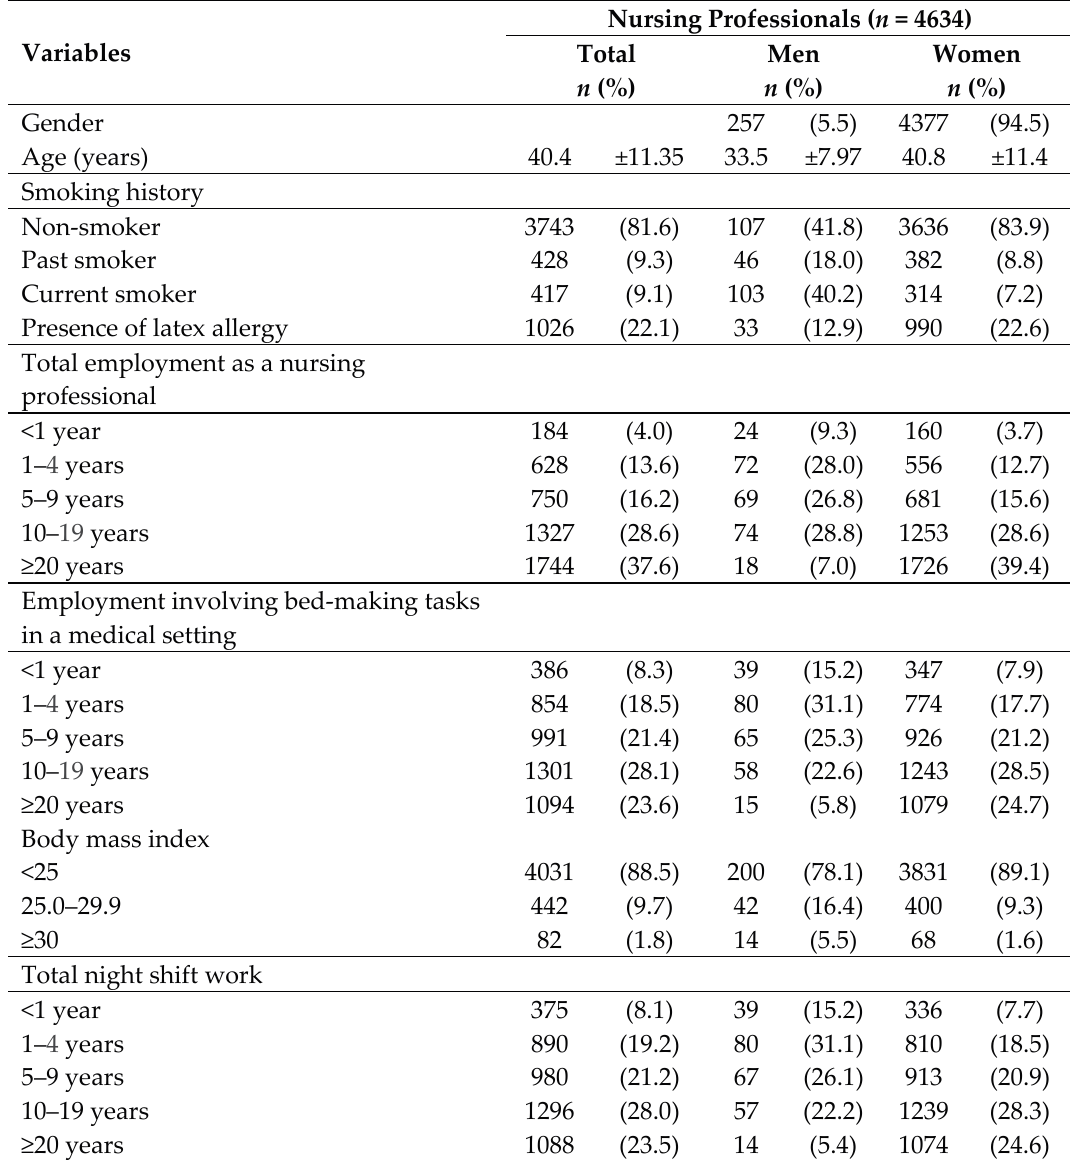
Table 1. Descriptive characteristics of the study